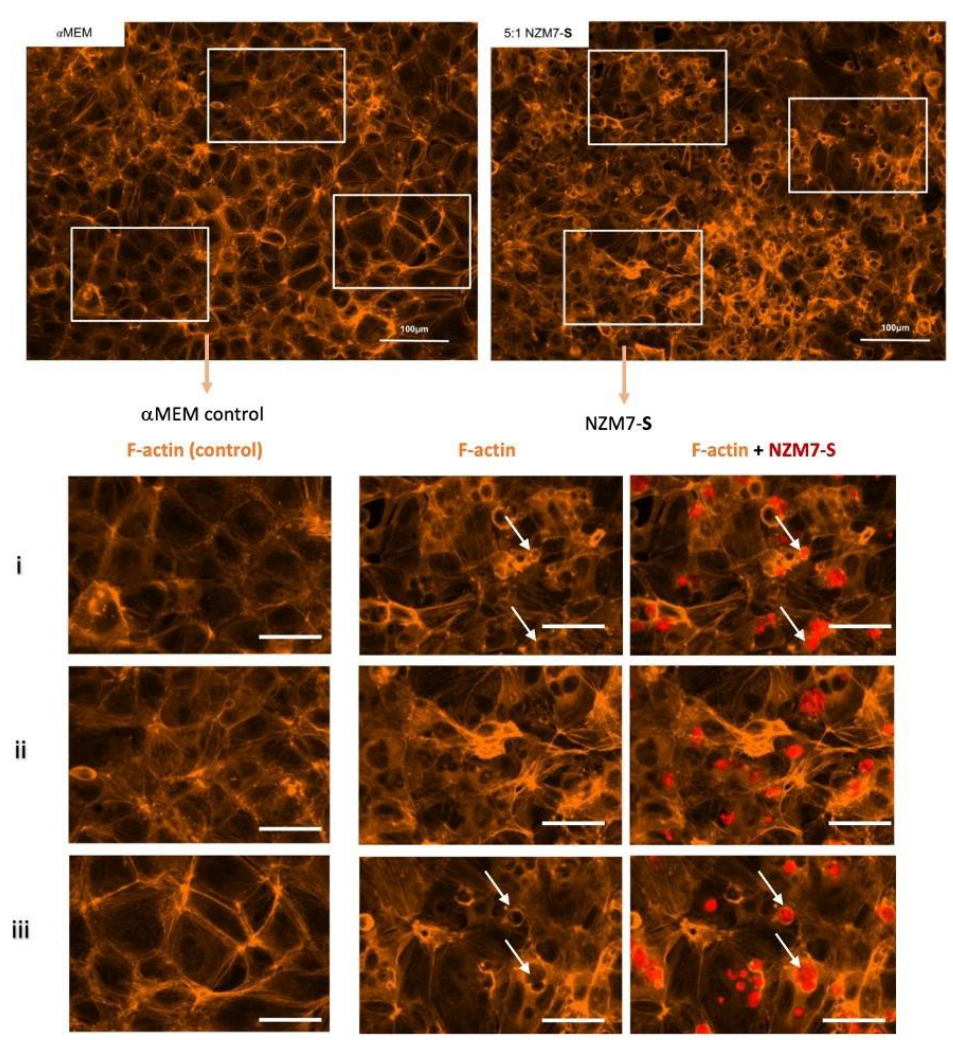
Figure 8. Expression of F-actin following the addition of 100,000 NZM7-S events to human cerebral microvascular endothelial cells. hCMVECs were seeded at 20,000 cells per well. After 48 h NZM7-S (red) was added in α MEM media and co-cultured for 4 h. Panels i – iii show expanded sections of the white boxes. Single left panel in i –iii shows αMEM control, and the two right panels show melanoma treated images. White arrows show ring-like F-actin structures. Full view images scale bar = 100 µm, cropped images scale bar = 50 µm. Images are representative of 2 independent experiments.